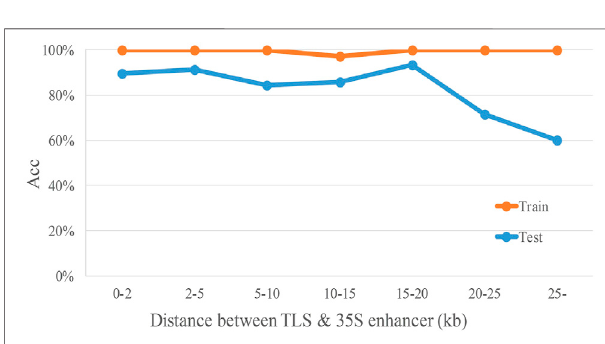
FIGURE 4 | Accuracy trend of TIMgo for cross-validation and independent testing of data within different distances. Train represents the Acc from fi vefold cross-validation with D299. Test represents the Acc from independent testing with D153. The x -axis indicates each distance interval, and the y -axis indicates the predictive